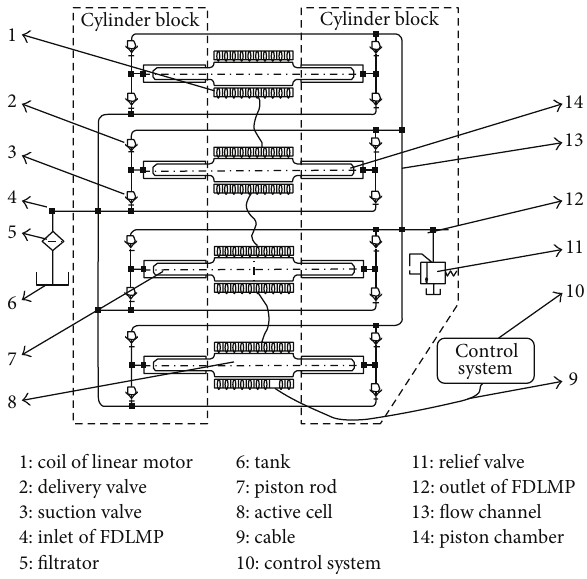
Figure 1: Schematic diagram of linear-motor-driven piston pump